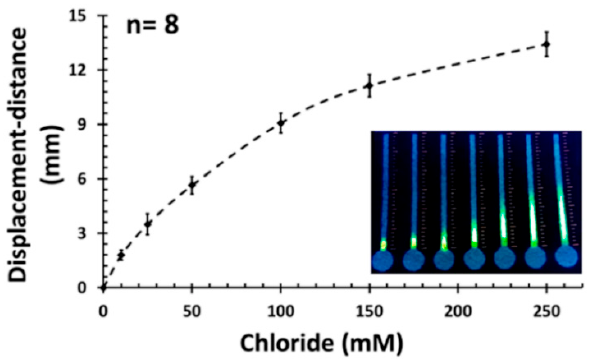
Figure 7. The relationship of fluorescent spot moving distance and the concentration of chloride microfluidic paper analytical devices. Adapted from Rahbar et al. [51]. Copyright 2019 American Chemical Society, 2019.